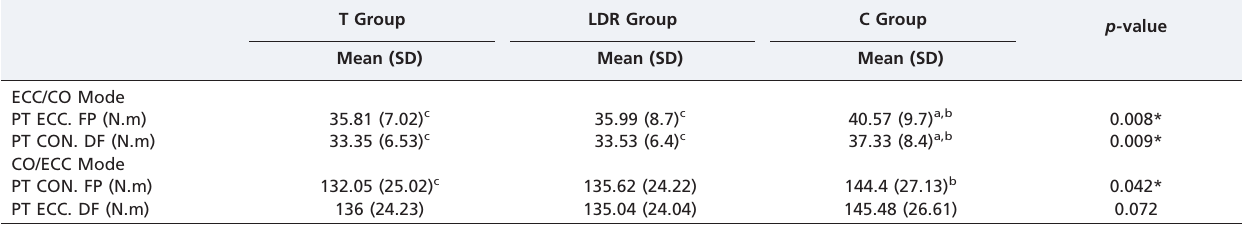
Table 2 - The means (SD) of the isokinetic variables at a velocity of 60 ˚ /s in the eccentric-concentric mode and concentric- eccentric mode and the comparison among the triathlete group, the long-distance runner group, and the control group.